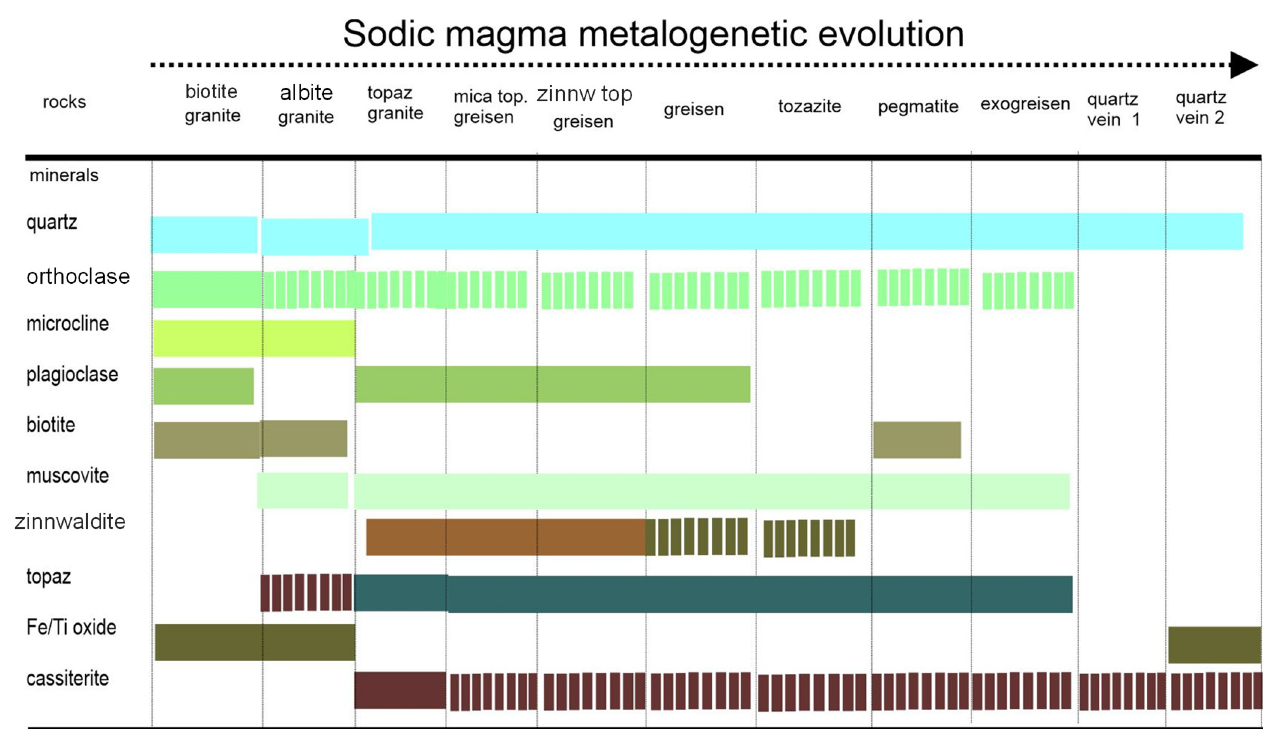
Figure 21. Paragenetic evolution of mineralized Massangana Massif rocks. The development of sodium magma and hydrothermal solutions is responsible for mineralizing rare metals in the Massangana Massif.